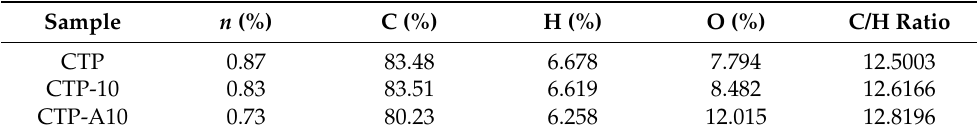
Table 3. Elemental content of the original CTP, the air oxidized 10 h CTP, and the catalytic air oxidized 10 h